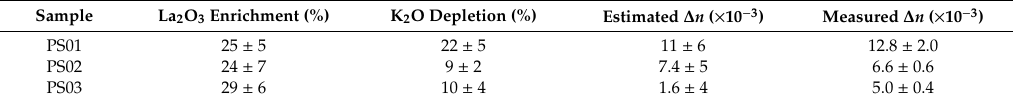
Table 3. Average local La 2 O 3 enrichment and K 2 O depletion at the center of the guiding region of three waveguides written at 695 nJ in samples PS01, PS02 and PS03. The index contrast indicated ( ∆ n = n local − n 0 ) has been determined from the local composition of the guiding structures (“Estimated values”) using the values in Table 2 and Equations (1) and (2) or using the near field images of the modes propagated by the structures at several wavelengths (“Measured values”). The values shown were averaged over three waveguides written in the same